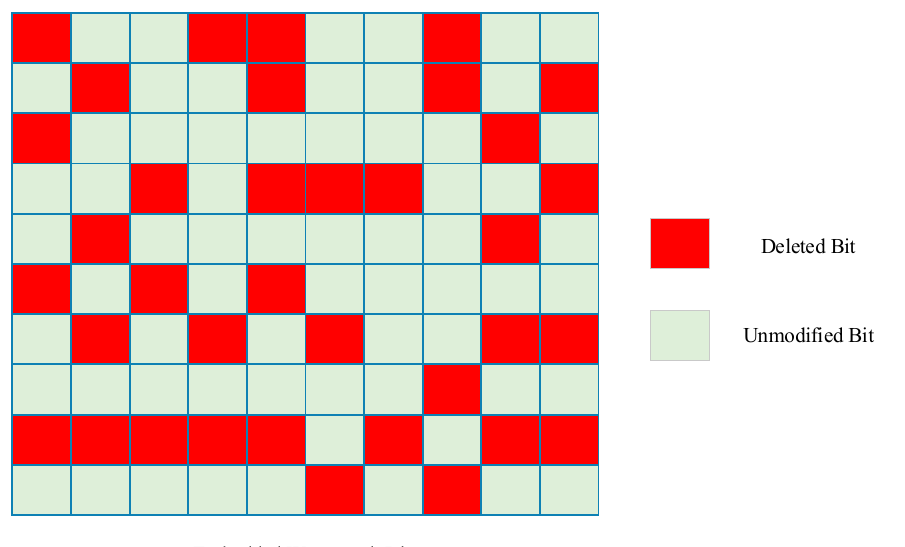
Figure 6. An example demonstrating Principle 4.